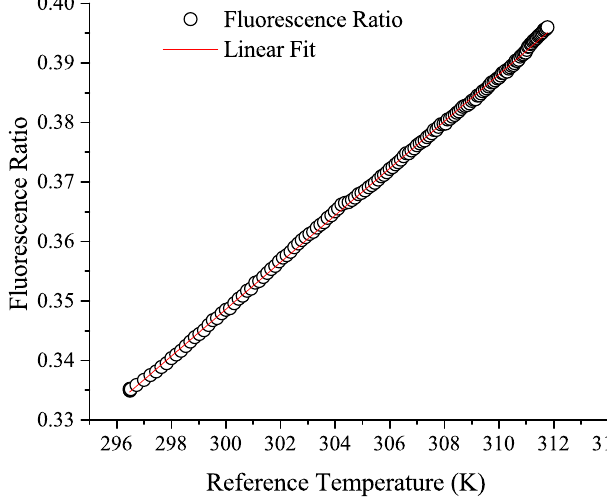
Figure 6. Fluorescence ratio vs . reference temperature for increasing temperature, R 2 =